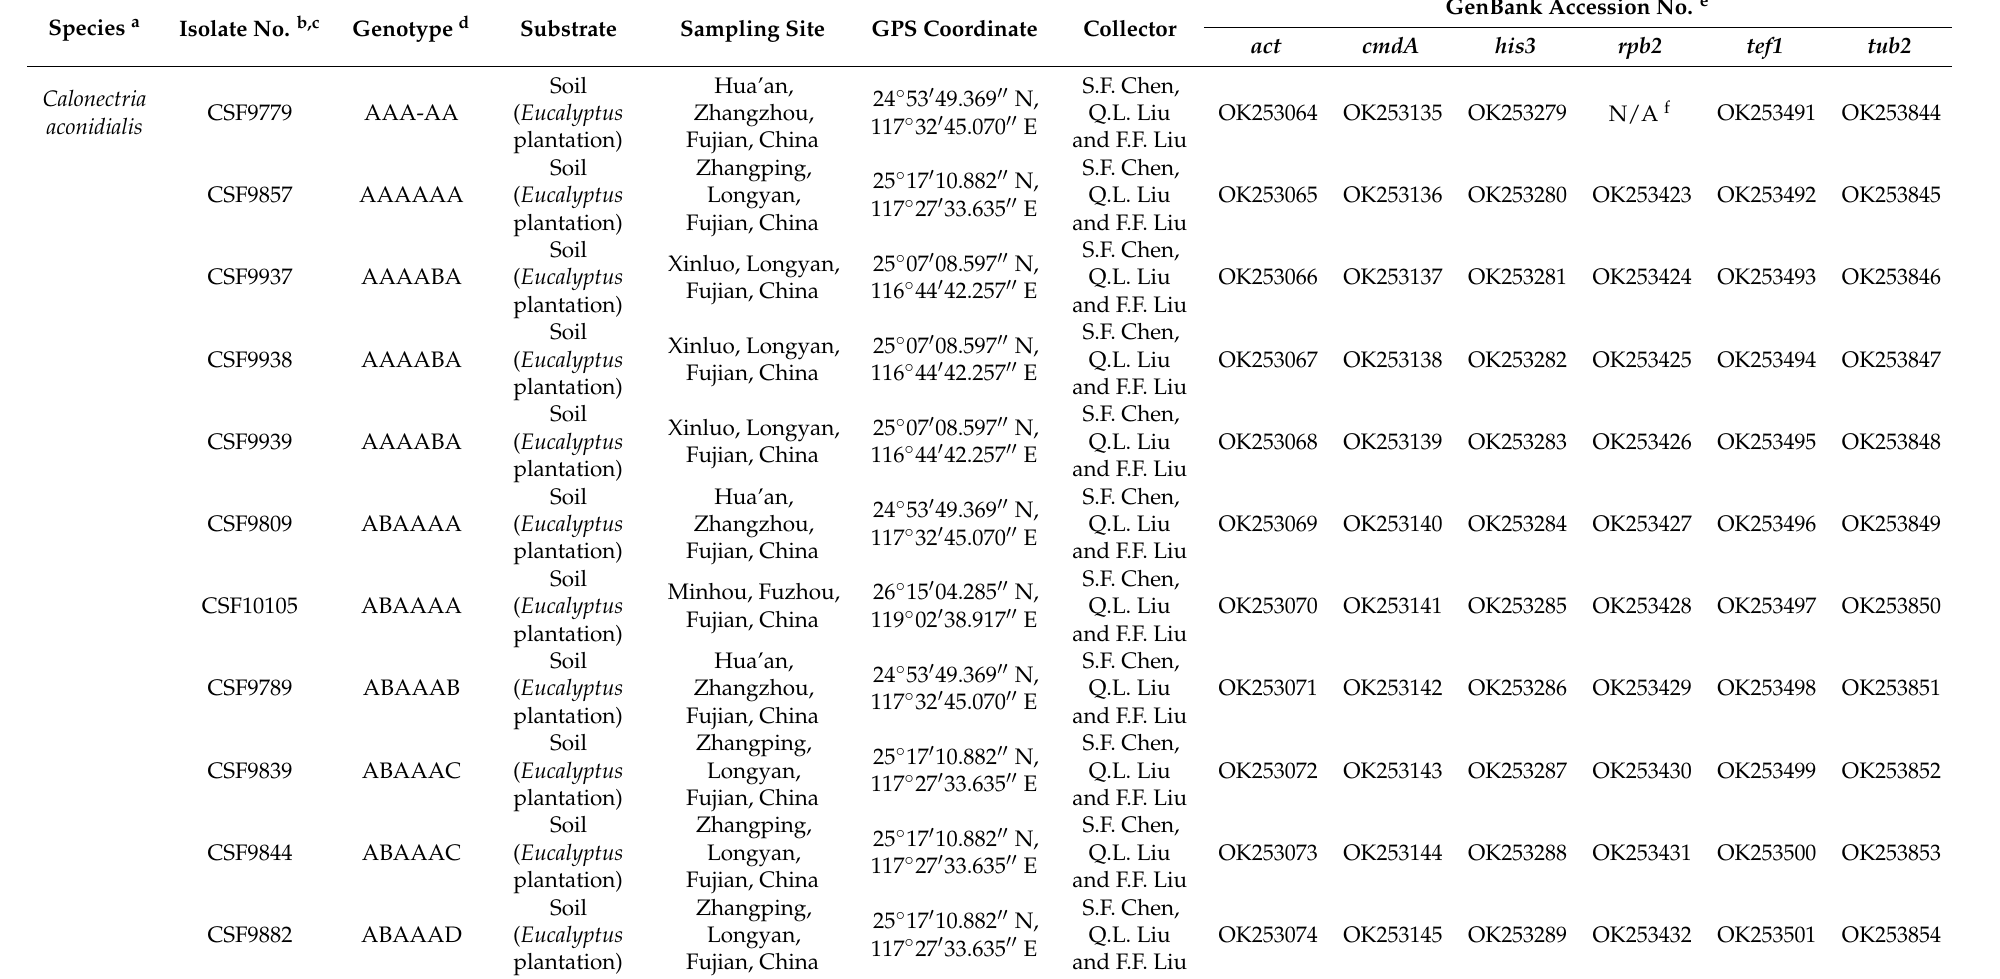
Table 2. Isolates sequenced in this study and used for phylogenetic analyses and morphological